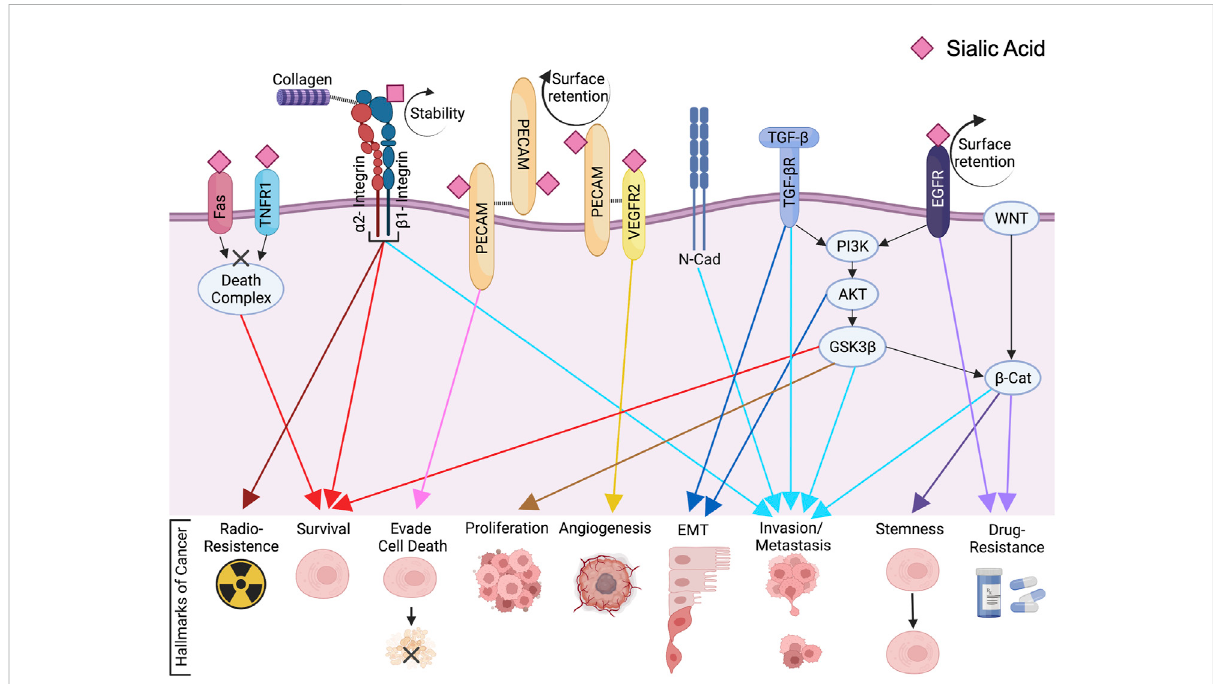
FIGURE 2 ST6Gal1-mediated Signaling Cascades in Cancer. The membrane bound N-glycoproteins synthesized and processed in secretory pathways (including Fas, TNFR1, β 1-integrin, PECAM, VEGFR2 and EGFR among others) are α 2,6 sialylated by ST6Gal1. This can affect protein cell surface retention, stability, clustering and/or activation. Through direct and indirect signaling pathways, ST6Gal1 promotes oncogenic characteristics in many cancers. The pink diamond represents α 2,6 linked sialic acid, although the full glycan structure is not shown for simpli fi cation. The fi gure was created using Biorender